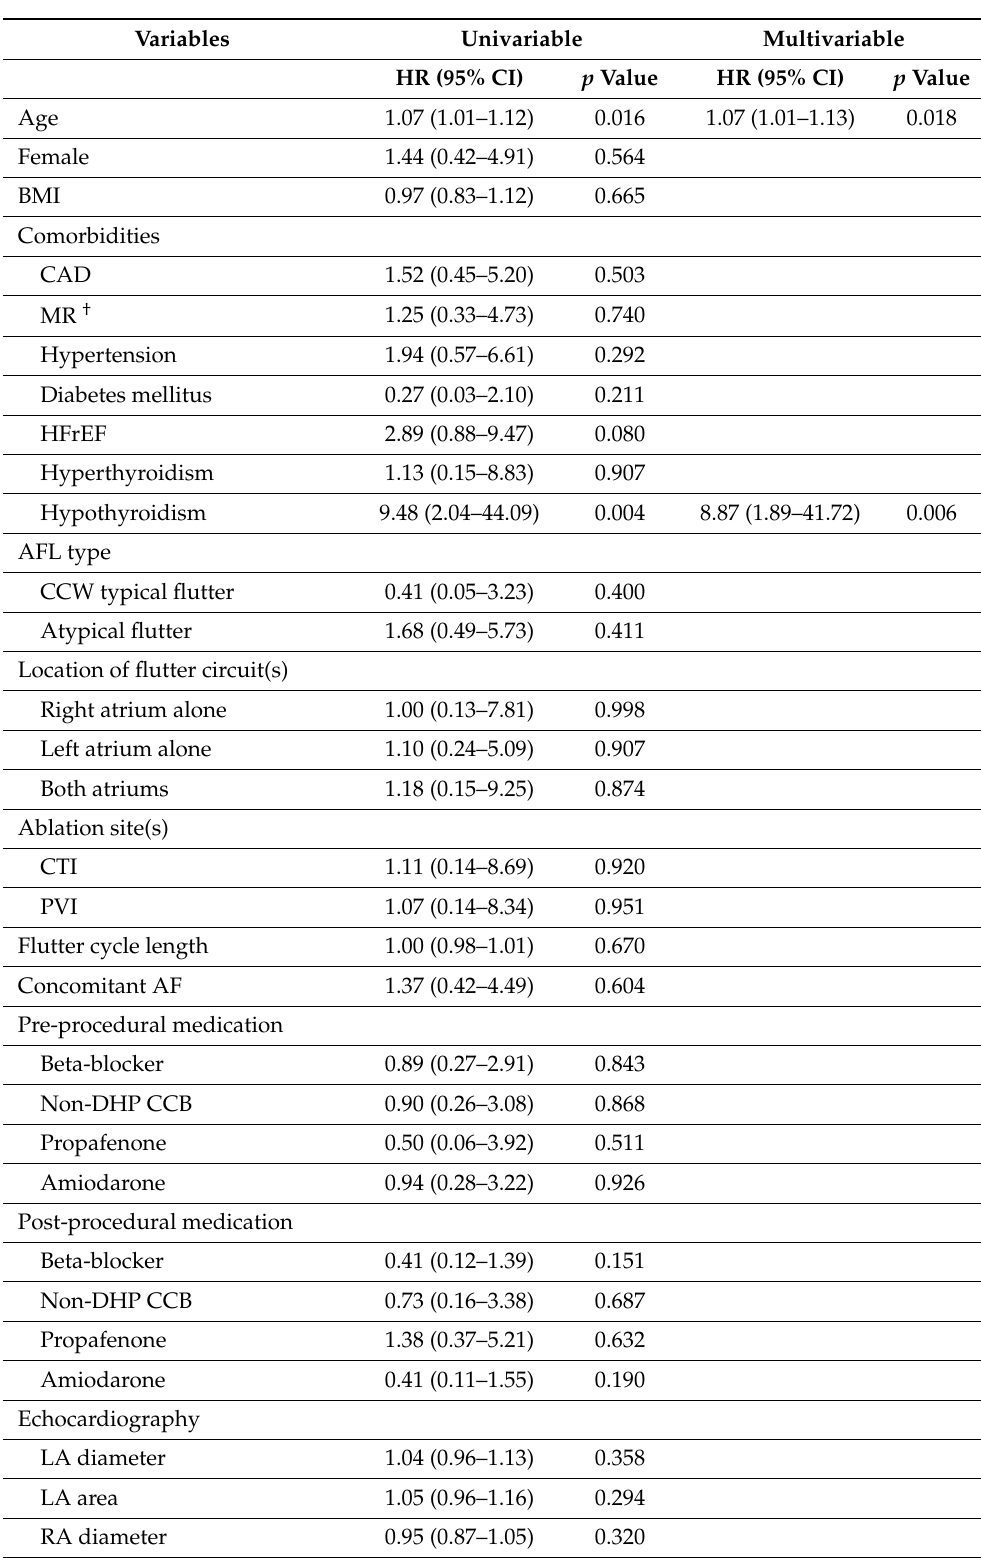
Table 3. Cox regression analysis of variables to predict delayed SND requiring a PPM after AFL termination ( n =